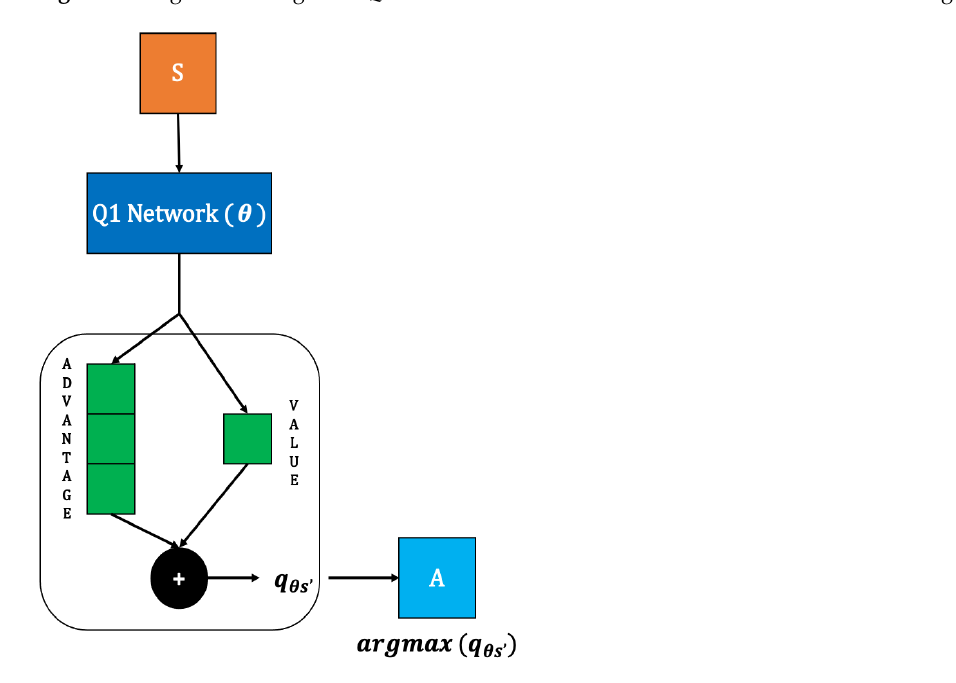
Figure 2. A figure showing Dueling DQN into two terms from the point of view of a Value stream and an Advantage